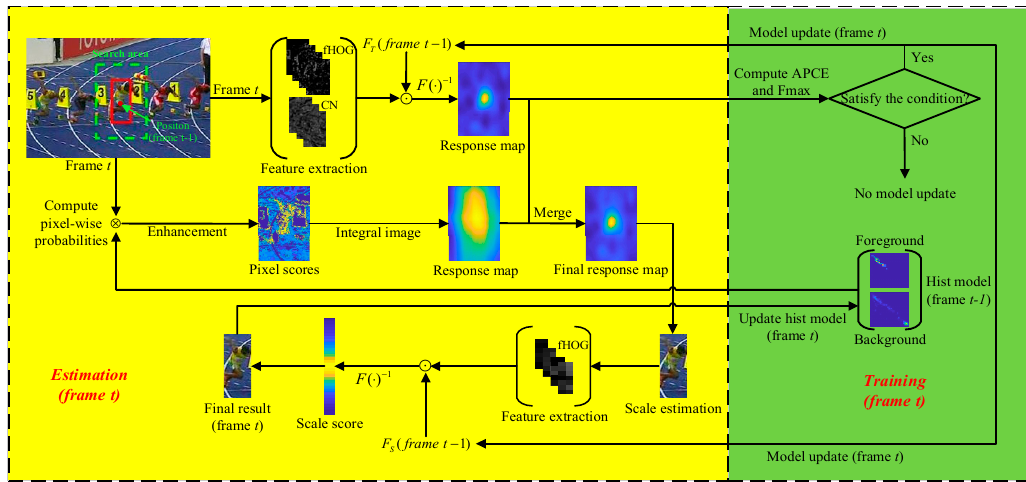
Figure 1. Overview of the proposed robust sum of template and pixel-wise learners (rStaple) algorithm.